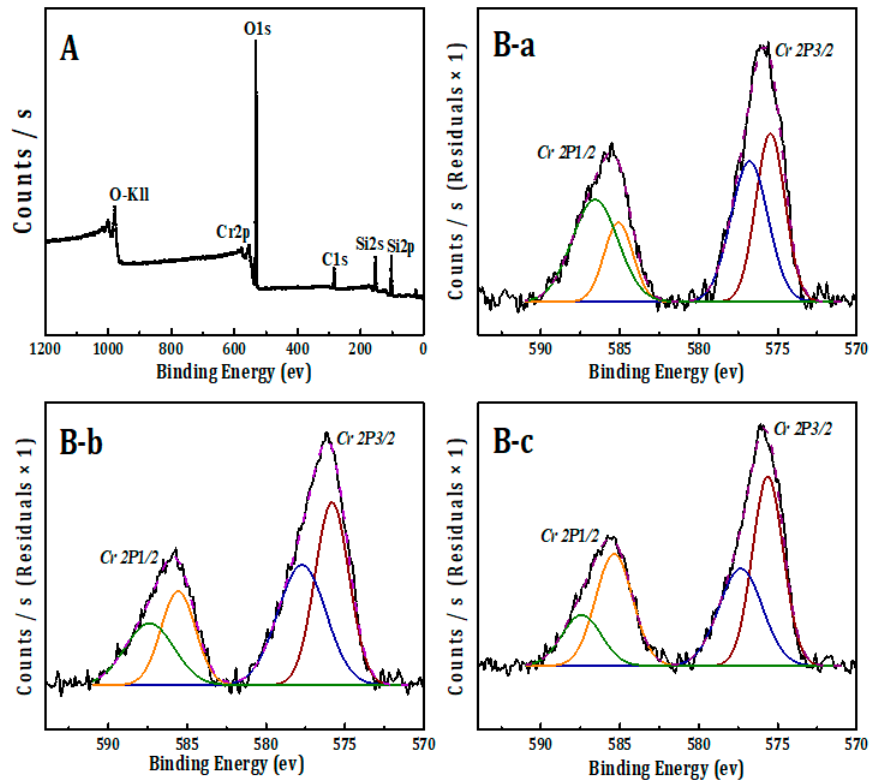
Figure 6. ( A ) XPS survey scan of Cr(4)/LPMS-130. ( B ) Cr2p XPS spectrum of Cr(y)/LPMS-130, prepared with various Cr loadings: ( B-a ) 4, ( B-b ) 8, and ( B-c ) 11 Cr wt %. Table 3. XPS data of Cr(y) / LPMS-130 (x = 4, 8, and 11 wt %) catalysts. Catalyst